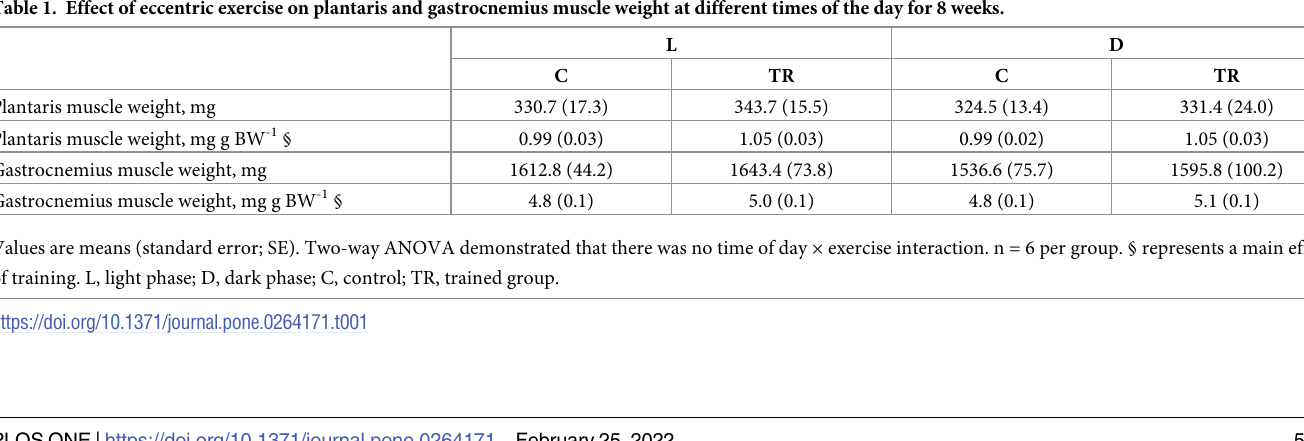
2 ( P = 0.9119; Fig 3D ), p70S6K phosphorylation significantly changed after exercise ( P < 0.001; Fig 3B ) and was higher in LPt0 rats than in DPt0 rats (+42.6%, P < 0.01; Fig 3B ).